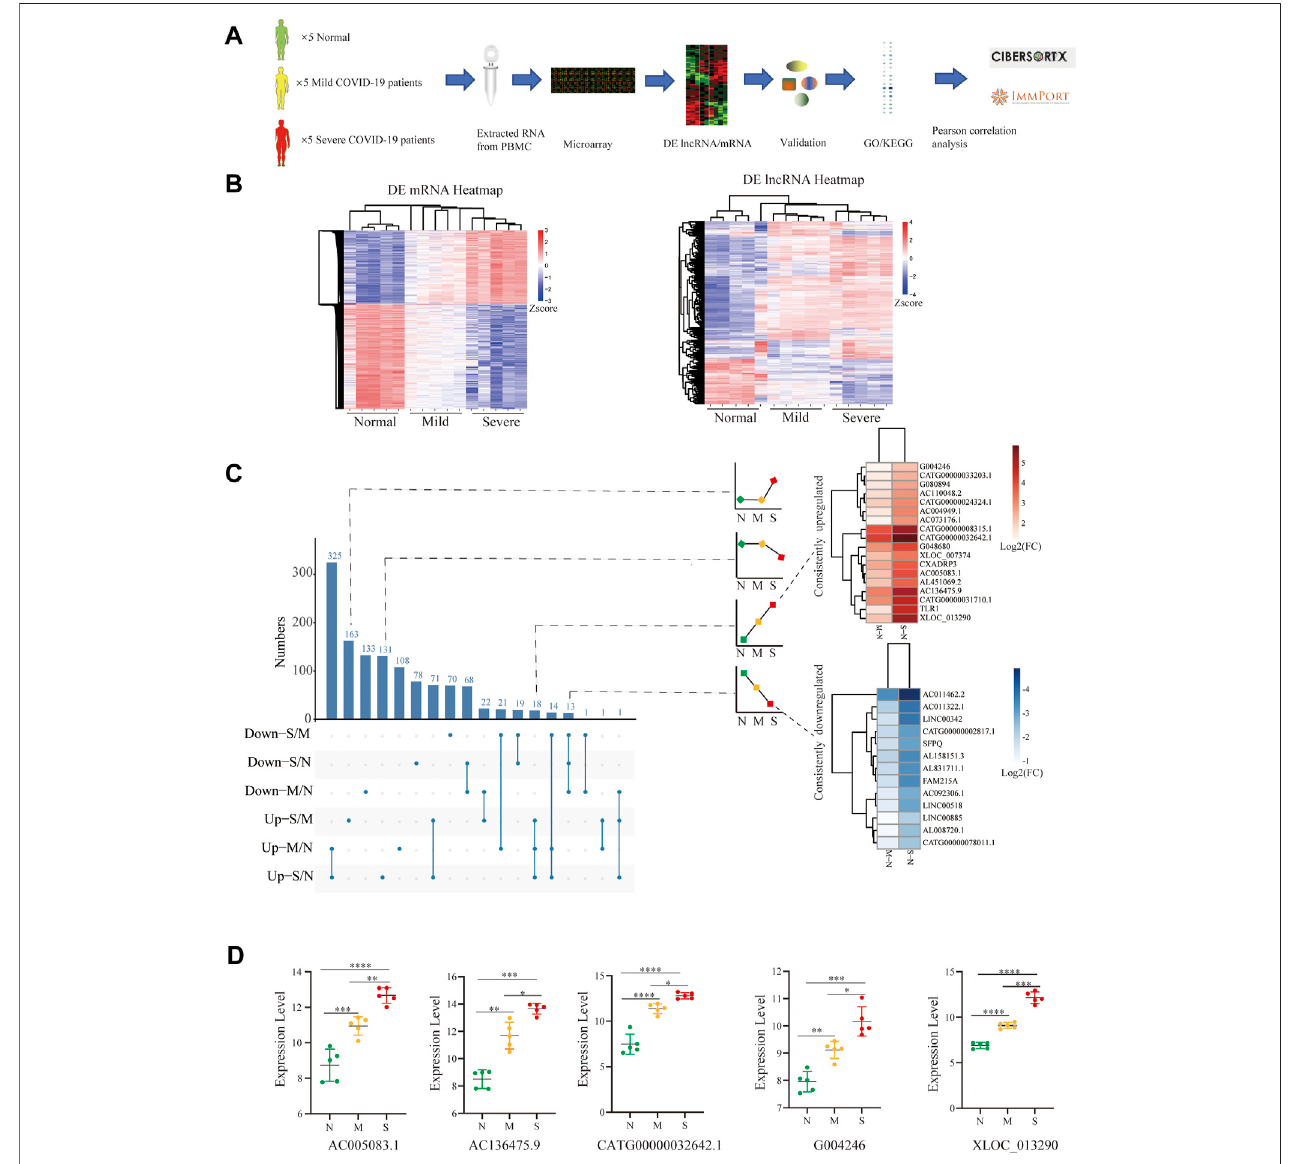
FIGURE 1 | Identi fi cation of biomarker lncRNAs. (A) Research experimental design. (B) Heatmap comparison of DE lncRNAs and mRNAs within PBMCs from normal control ( n = 5), mild ( n = 5), and severe ( n = 5) patients; each row and column respectively represent a separate gene and individual. (C) UpSet plot shows the number of DE lncRNAs with different tendencies; the heatmap shows the consistently increased or decreased lncRNAs by log2FC between mild vs. normal and severe vs. normal. (D) Filtered by p -value & 0.01 and the length of lncRNAs among 400 – 3000 nts and the difference between pairwise combinations of two groups, with expression of lncRNAs in each group. N (Normal: n = 5), M (Mild: n = 5), and S (Severe: n = 5). Comparisons were done using the ANOVA test. Mild and severe patients were colored by yellow and red, respectively. Statistical comparisons are indicated by the arrows; p p < 0.05, ** p < 0.01, *** p < 0.001, **** p < 0.0001; Mild and severe patients were colored by yellow and red,